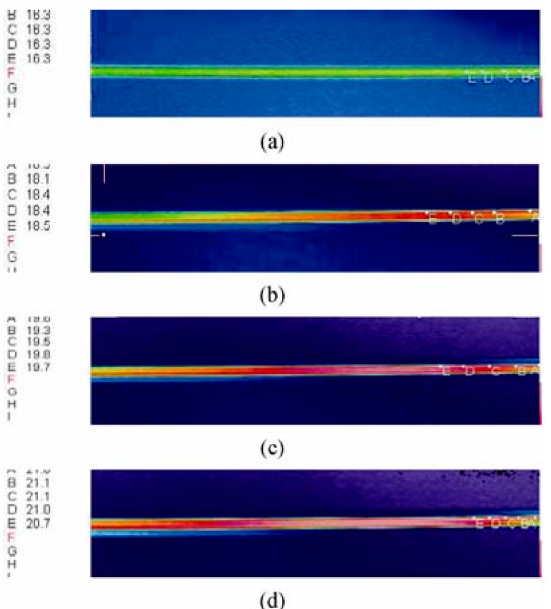
Figure 4. Surface temperature measured by Liu et al. [57] in a microtube of 44.2 µ m inner diameter and 140 mm length at various Reynolds numbers. ( a ) Re = 0; ( b ) Re = 297.2; ( c ) Re = 491.8; ( d ) Re = 692. Temperatures for various locations in the channel are provided in ◦ C in the left part of the image. Reprinted by permission from Ref. [57], Journal of Thermal Science, Copyright © 2022